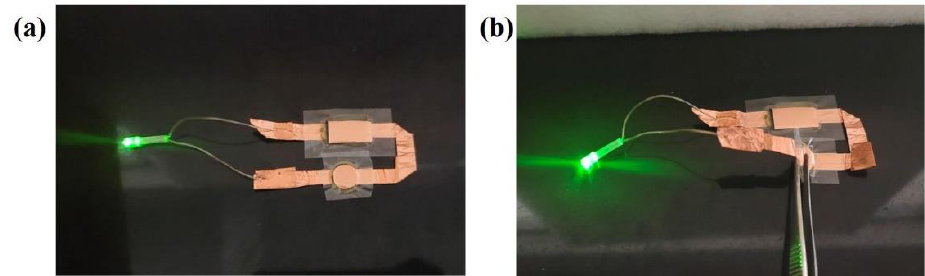
Figure 9. Digital photo of a LED activated by the supercapacitor under ( a ) an unfolded condition and ( b ) a bent state at 90°.